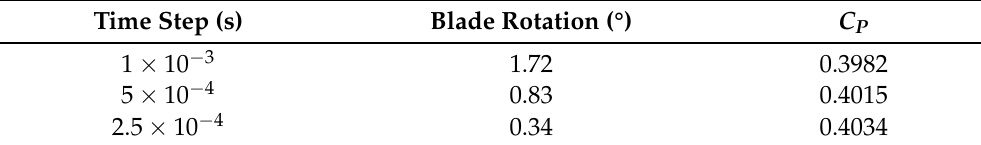
Figure 4. Average power coefficient obtained from single-phase flow simulations. ( a ) Sensitivity to turbulence model at λ = 6; ( b ) C P calculated with the TSST model for various TSRs. Table 2. Effect of time-step size on C P at λ =